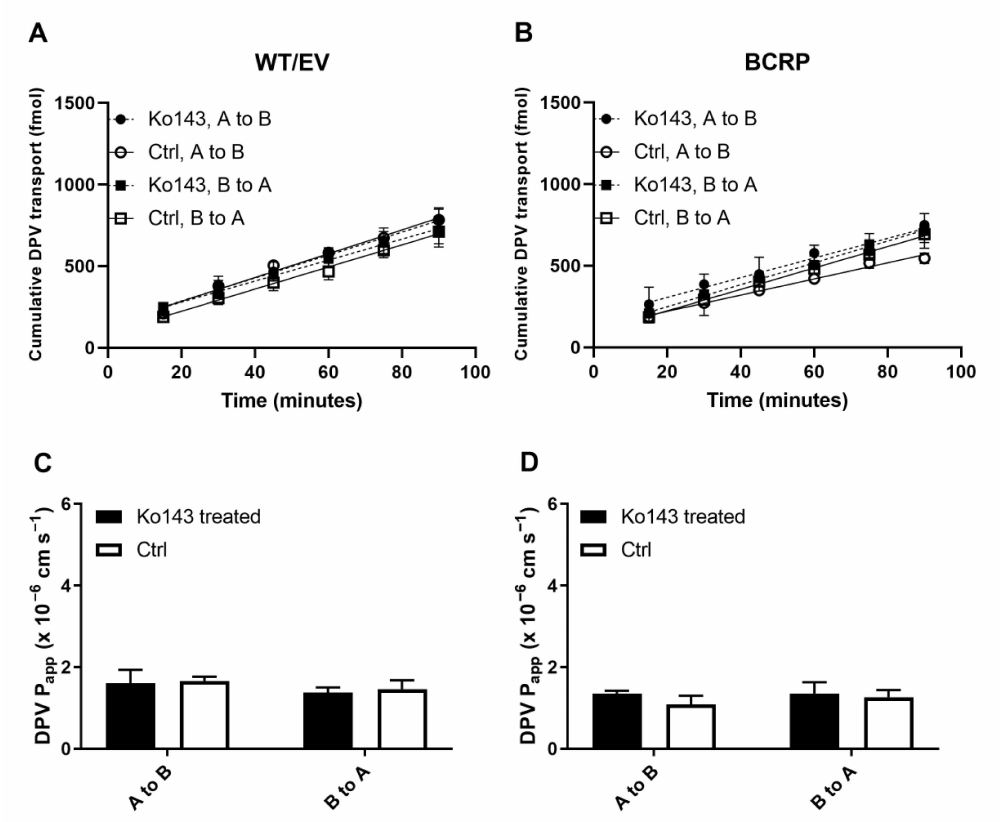
Figure 3. DPV bi-directional transport across MDCKII WT/EV ( A ) and BCRP ( B ) cell monolayers with and without transporter inhibitors (Ko143 and Ctrl); P app values obtained from the transport assays ( C , D ). Data represented as mean ± SD of three biological